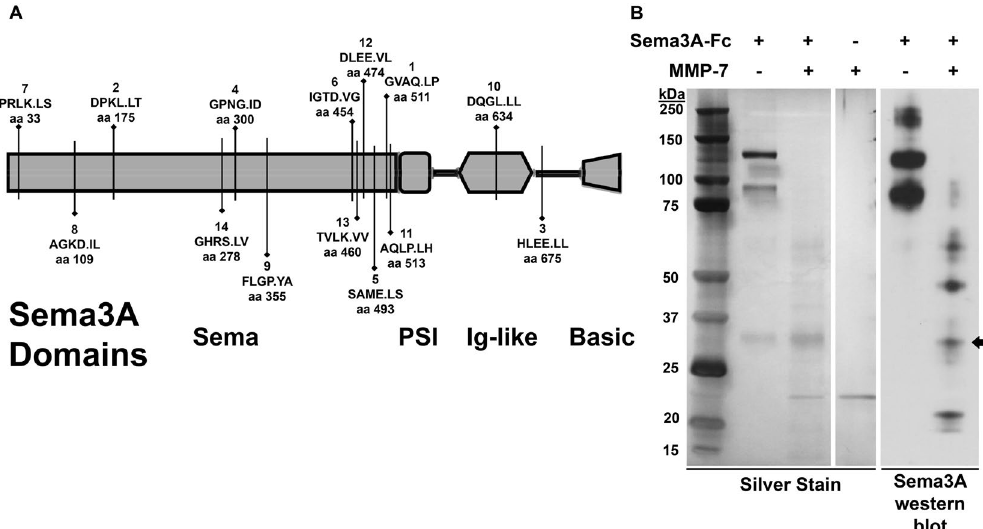
Figure 7. Recombinant Sema3A-Fc is digested by MMP-7. ( A ) MMP-7 in silico digestion of Sema3A using SitePrediction online software. Shown is a schematic of Sema3A with its domains (sema, plexin/semaphorin/ integrin (PSI), immunoglobulin (Ig)-like, basic). Each line represents a cleavage site with > 95% specificity. The bolded number is the rank in average score. Below rank average score is the amino acid sequence with the P1 cleavage site (cleaves at period). Amino acid sequence is based on UniProt ID Q14563, which includes the signal sequence not shown in the schematic. ( B ) Sema3A-Fc (0.75 µ g) was incubated alone or with MMP-7 (0.08 µ g) overnight. A silver stain and western blot against Sema3A indicate MMP-7 fragments Sema3A into multiple smaller sub bands including a 30 kDa band indicated by an